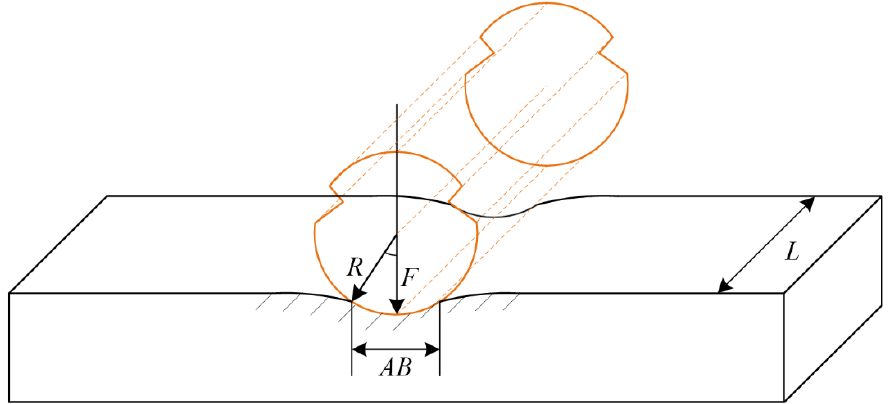
Figure 8. Geometric model of the C-Cu contacts in the pantograph-contact line system.